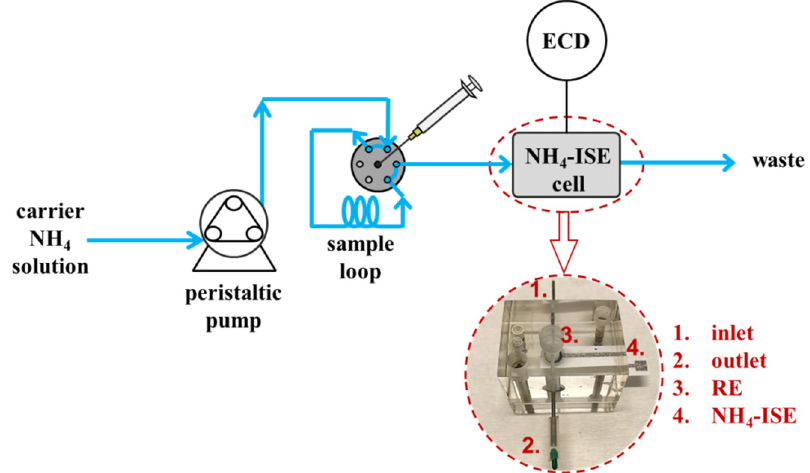
Figure 1. Schematic presentation of the FIA device used for ammonium sensing with the potentiometric flow cell. RE—reference electrode; ECD—electrochemical detector.